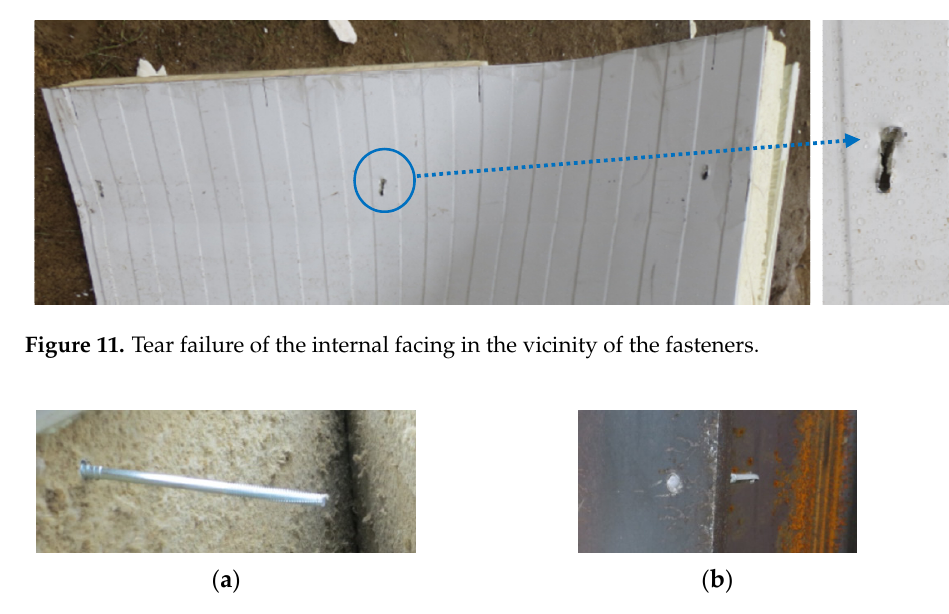
Figure 12. Shear failure of the fastener. ( a ) The upper part of the sheared fastener left in the sandwich panel’s external facing and ( b ) the lower part of the sheared fastener left in the steel column flange.